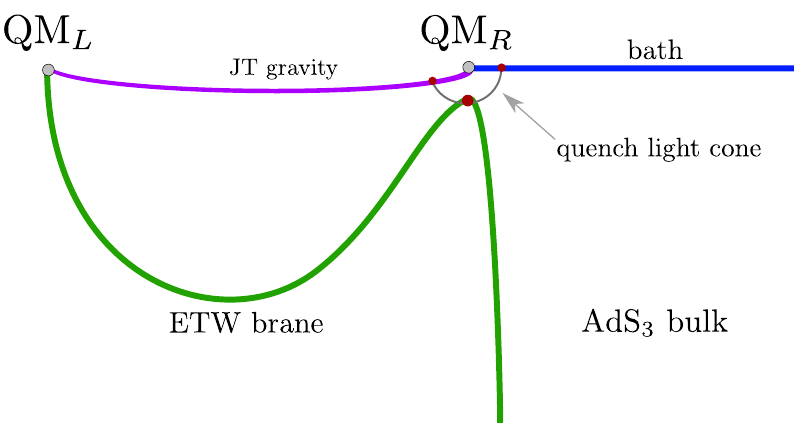
Figure 2. The evaporating black hole model of [2, 3] summarized in one